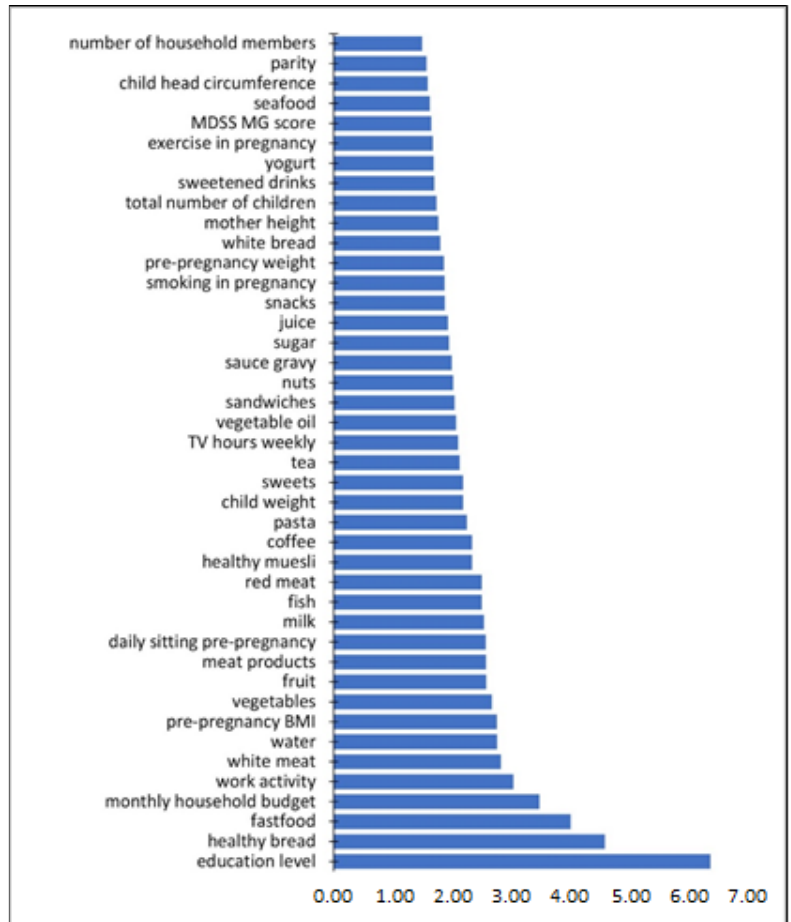
Figure 4. variable importance in the random forest classifier. Figure 4. Variable importance in the random forest